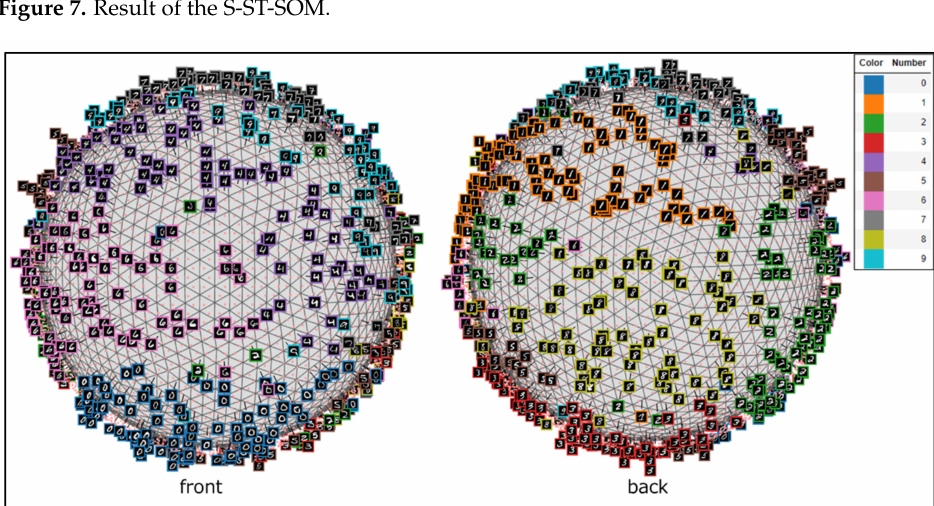
Figure 7. Result of the S-ST-SOM.